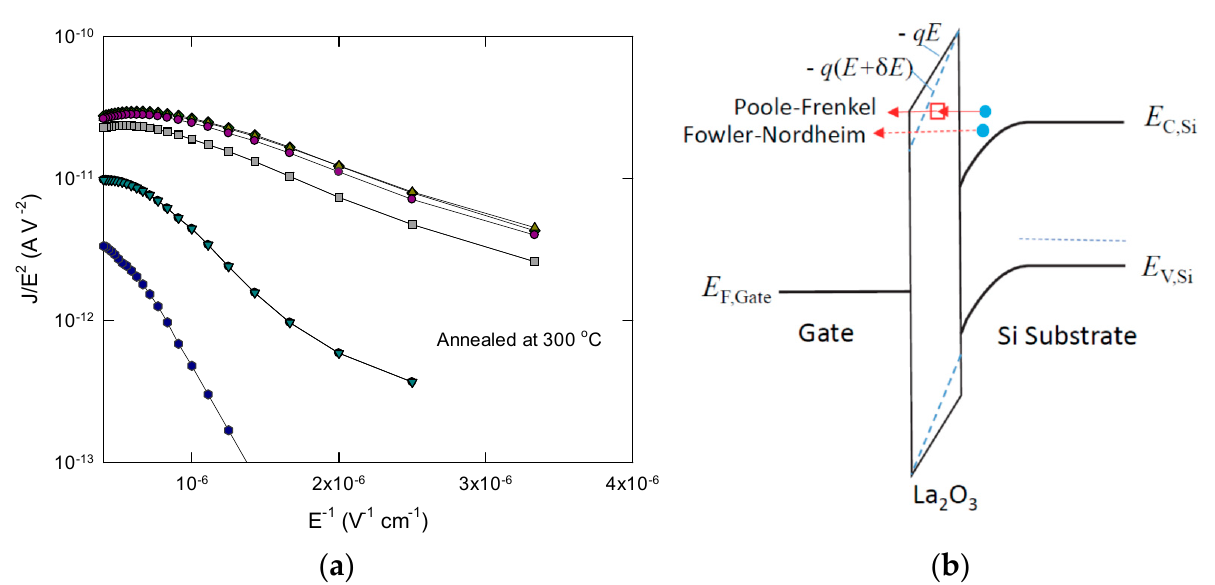
Figure 6. ( a ) Leakage currents at some locations of 300 °C annealed sample were several orders of magnitude larger than other locations and these characteristics can be plotted well with the Fowler-Nordheim relationship. The FN slope changes from 3.74–7.95 × 10 5 V/cm. ( b ) A possible mechanism for the leakage current enhancement involving local electric field enhancement due to surface roughness ( δ E ). The barrier narrowing (blue dashed line) makes the FN tunneling possible (arrow with dotted line) and may convert the Poole–Frenkel conduction into FN tunneling (arrow with solid line).